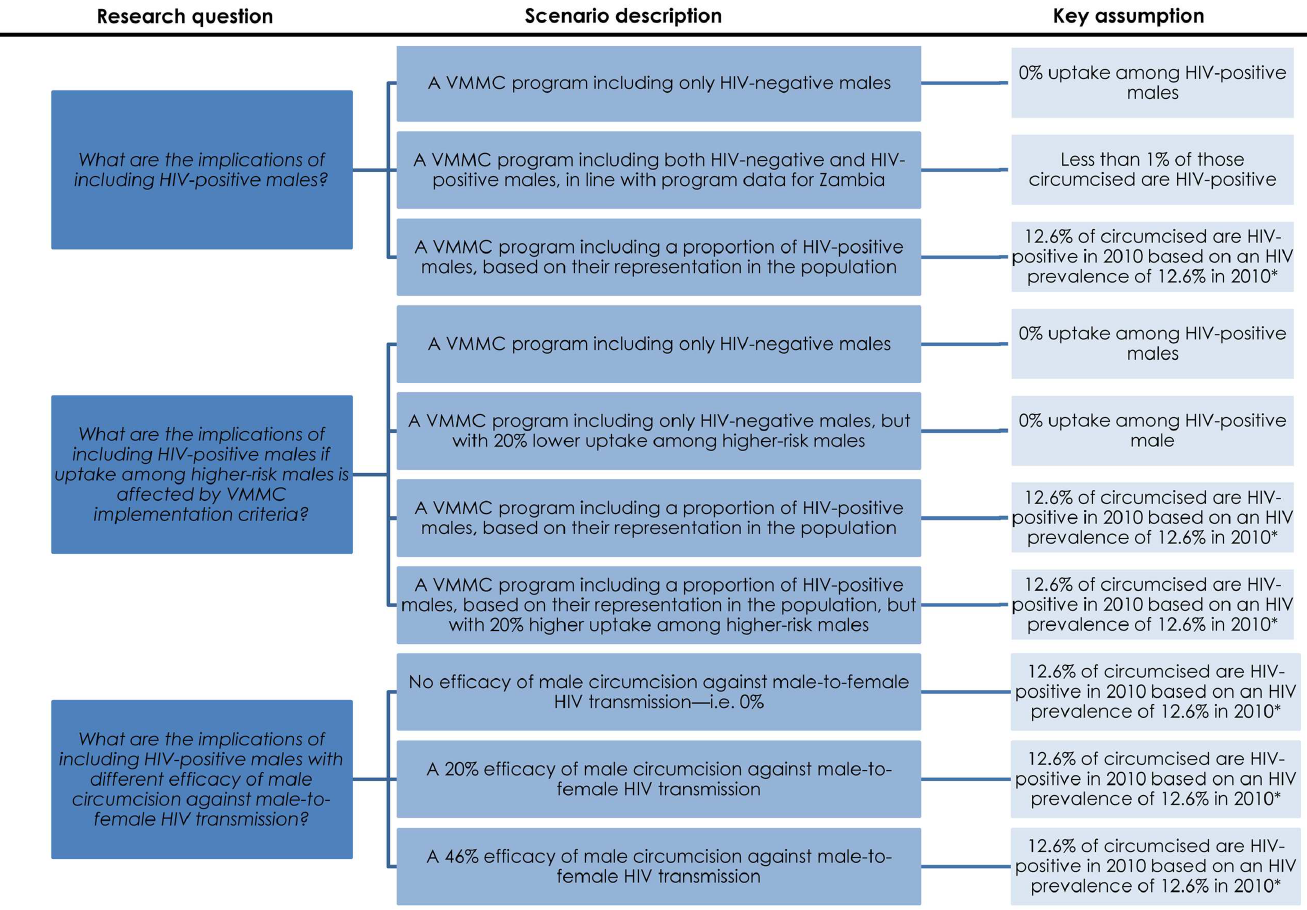
Fig 1. Diagram summarizing researchquestions and modeled intervention scenarios investigated in this study. * This fraction changeswith the temporalchangesin HIV prevalence Effectiveness is definedas the number of VMMCs neededto avert one HIV infection. VMMC: Voluntary medical male